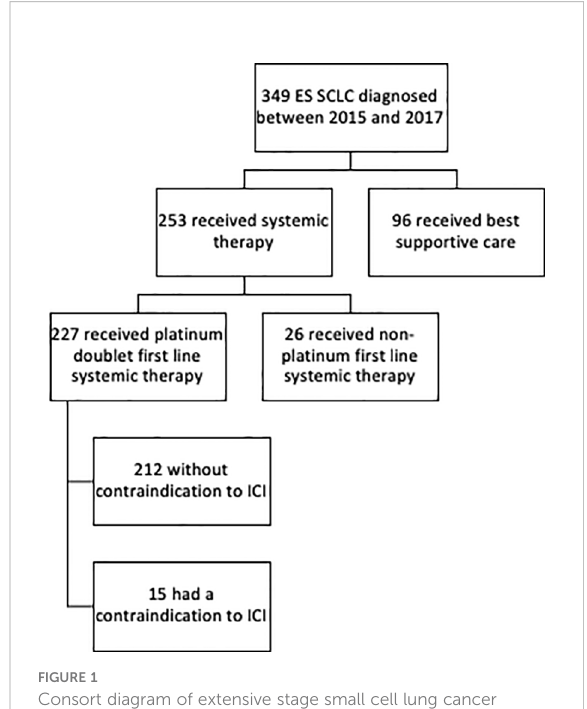
FIGURE 1 Consort diagram of extensive stage small cell lung cancer dataset assessing eligibility for ICI.